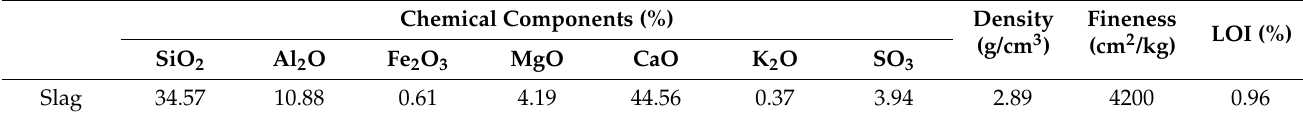
Table 1. Chemical components and physical properties used in slag.